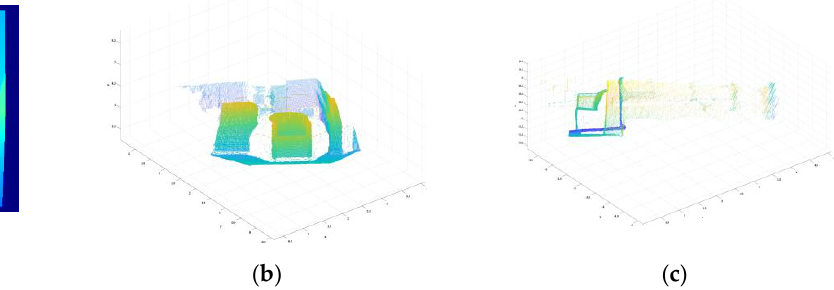
Figure 4. Resampling interpolation (INTER_AREA) results for depth images (PSNR = 33.570 dB). ( a ), depth image; ( b ), front view of the point cloud map of the depth image; ( c ), side view of the point cloud map of the depth image.